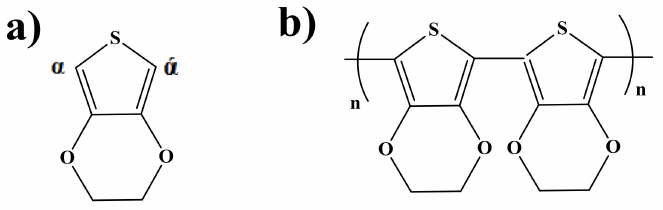
Figure 10. ( a ) α and ά positions of EDOT are included during polymerization; ( b ) structure of PEDOT polymer.